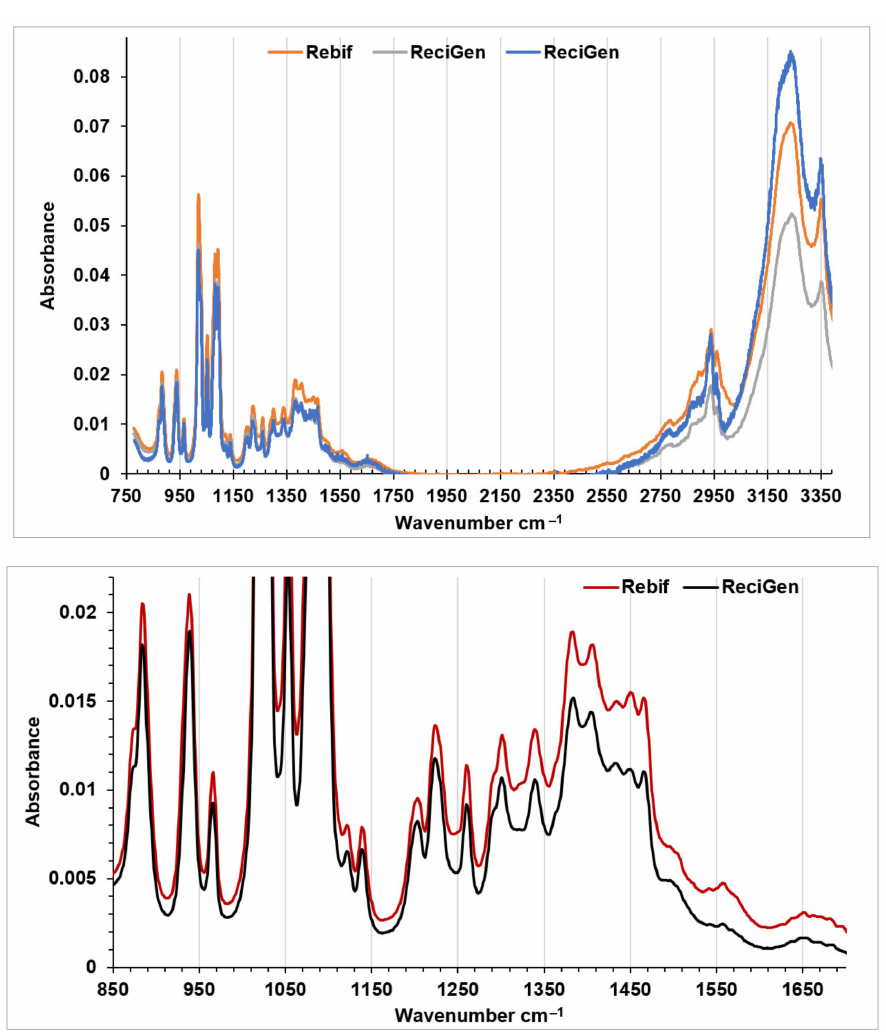
Figure 2. FTIR spectra of lyophilized solution of IFN β -1 preparations in Rebif and